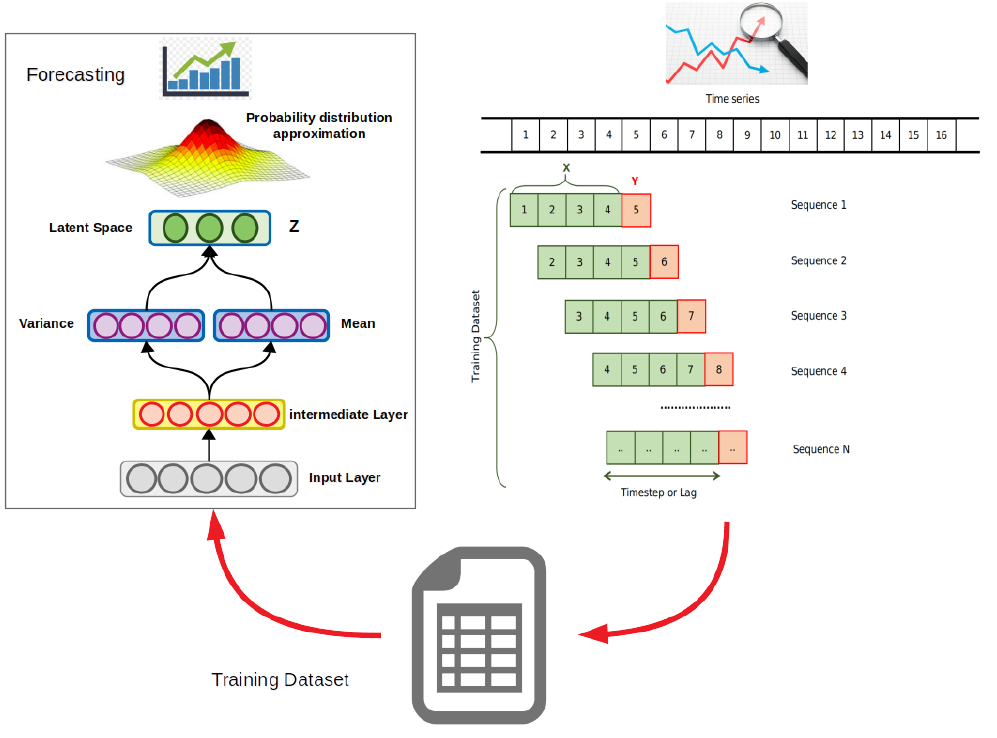
Figure 4. VAE-driven